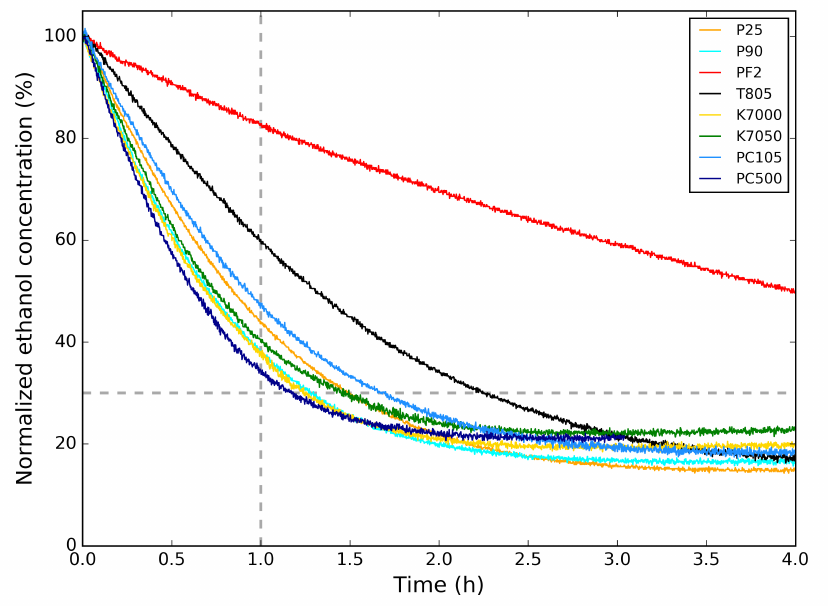
Figure 2. K–M absorbance spectrum for different TiO 2 powders. The inset shows the region from 365–450 nm.